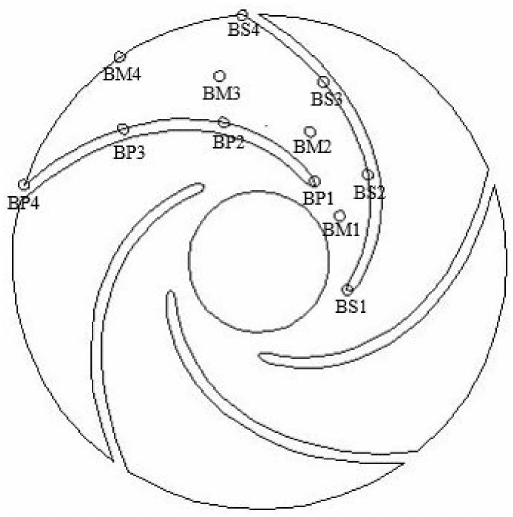
Figure 4. Monitoring points position in an automotive electronic water